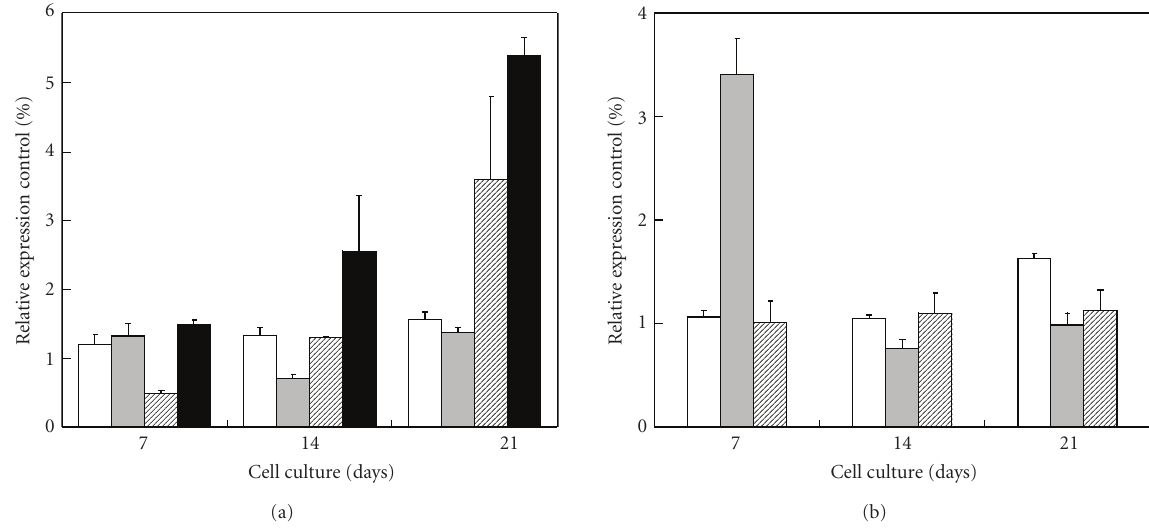
Figure 9: qPCR analysis of the indicated genes from NPI cell monolayers cocultivated in the presence of ESC for the indicated time periods. (a) PDX-1 (open bars), NeuroD (gray bars), Nkx6.1 (hatched bars), and c-kit (filled bars). (b) Insulin (open bars), Glut-2 (hatched bars), and GK (filled bars). The reported results are expressed as a percentage out of untreated control NPI cell monolayers. Data are shown as means ± SD from 3